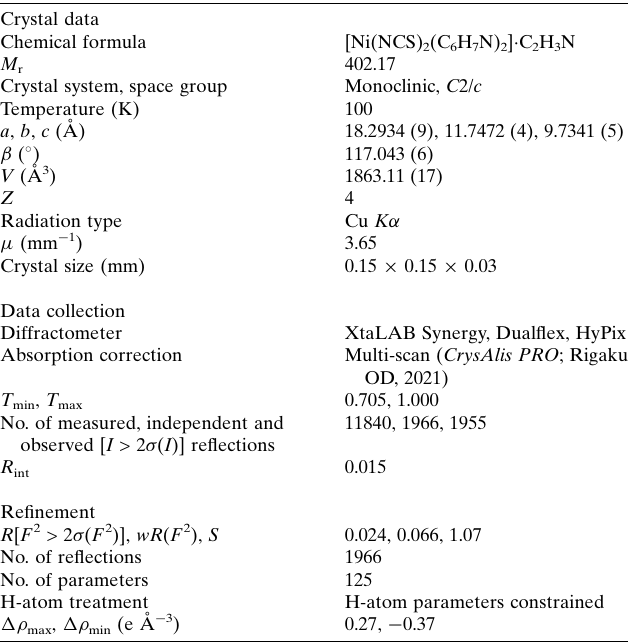
Crystal data Chemical